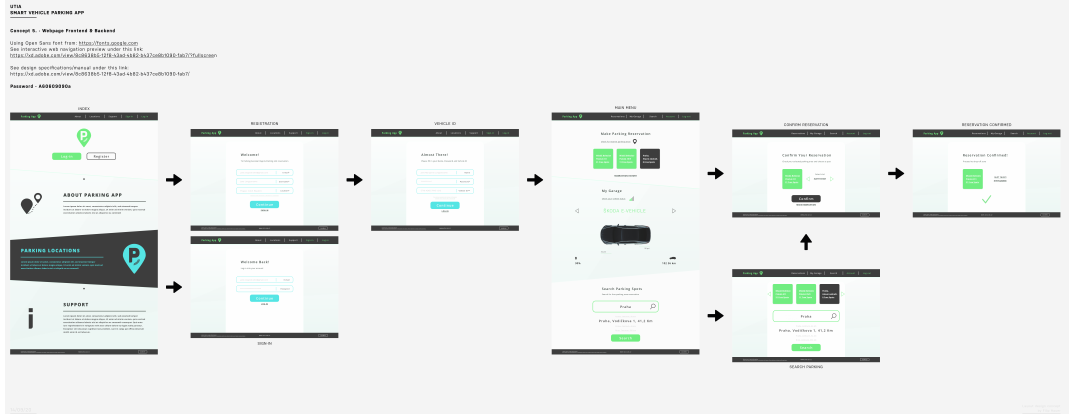
Figure 8. Web human–machine